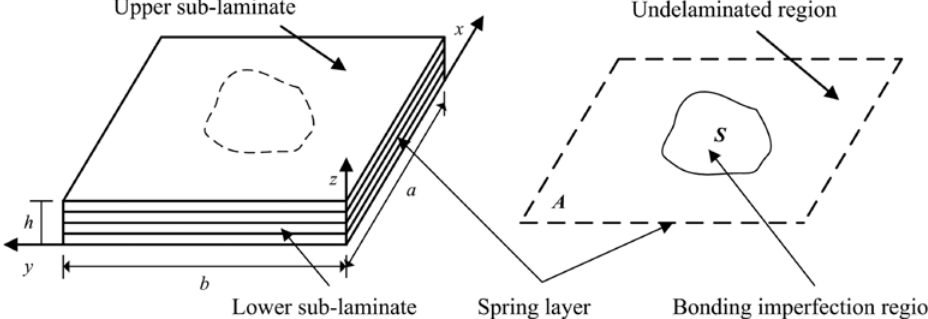
Figure 1: Geometry of delaminated composite laminated